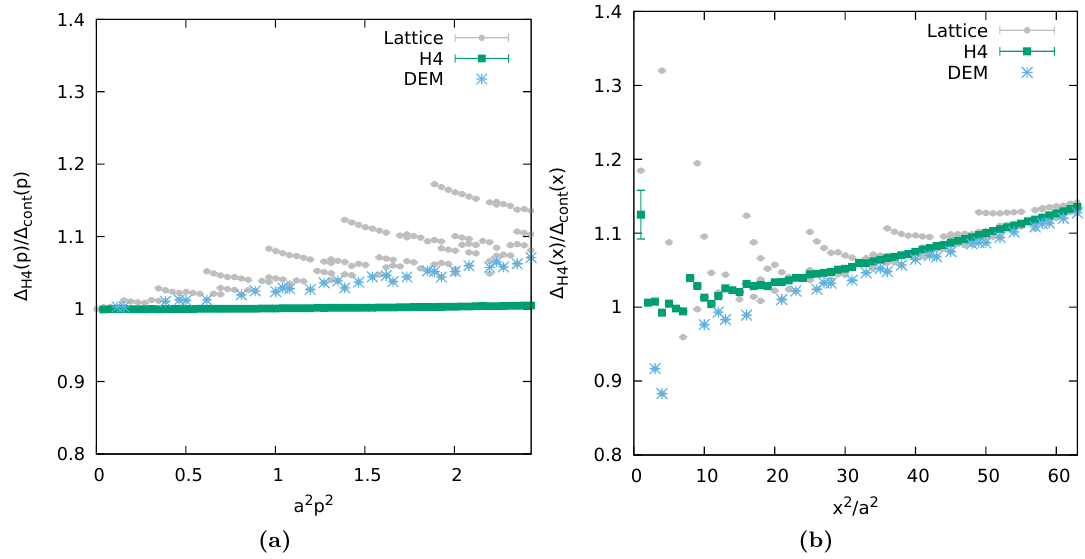
Figure 2. Ratio of Klein-Gordon propagator in a 32 4 lattice with respect to the continuum one in momentum space (a) and position-space (b). Grey circles represent the original lattice data and green squares the result of applying the generalized H4 method. For comparison, the results of a democratic cut with an angle smaller than 30 ◦ with diagonal have been added as light blue